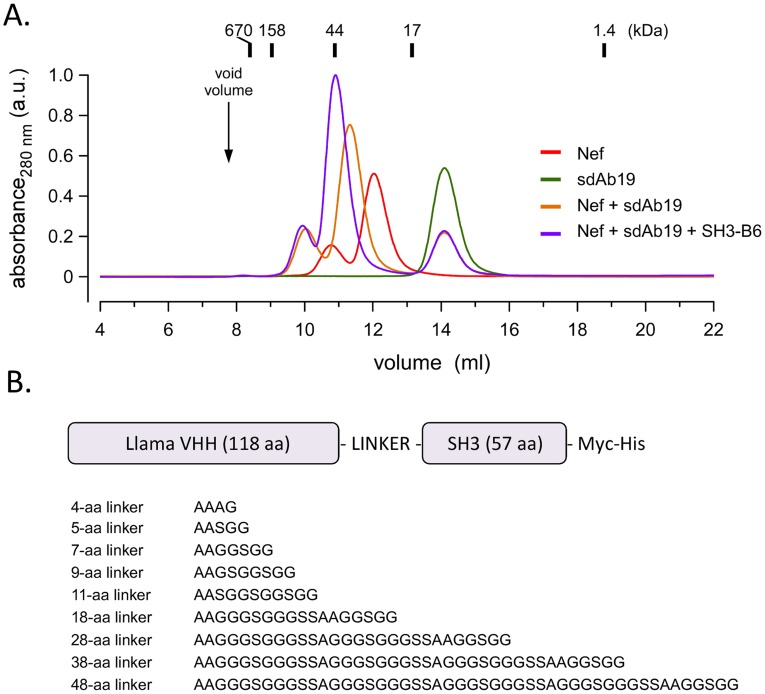
Design of a VHH-SH3 fusion protein (Neffin) targeted against HIV-1 Nef.(A) Size exclusion chromatography analysis confirming the expected molecular sizes for the monomeric Nef, sdAb19, and SH3-B6 proteins and for the dimeric sdAb19/Nef and the trimeric sdAb19/Nef/SH3-B6 complexes. (B) Domain organization of Neffin and the amino acid sequences of the different linkers tested for joining of sdAb19 and SH3-B6.